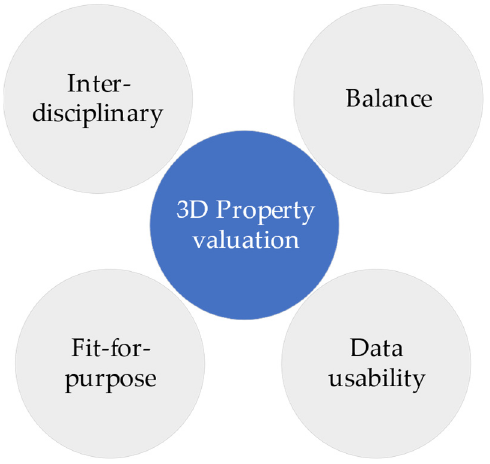
Figure 3. The essential features of 3DPV.